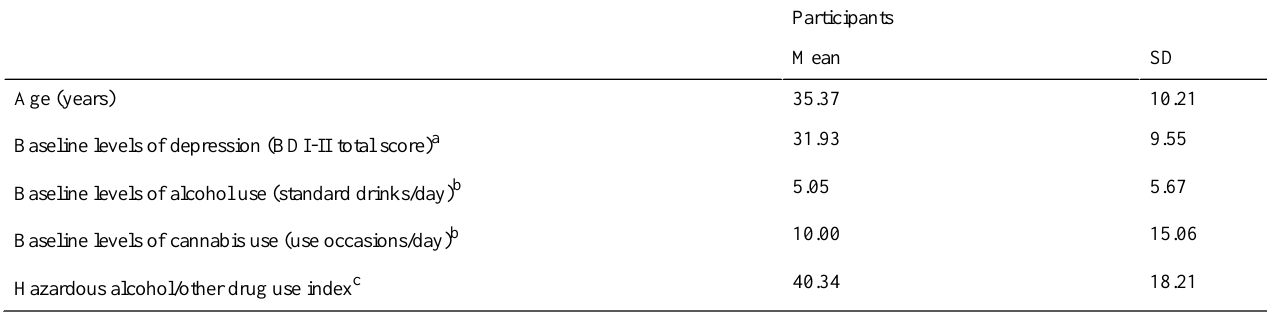
Table 1. Baseline demographics of participants in a randomized controlled trial of clinician-assisted computerized cognitive behavior therapy for coexisting depression and alcohol/other drug use problems (N = 97)